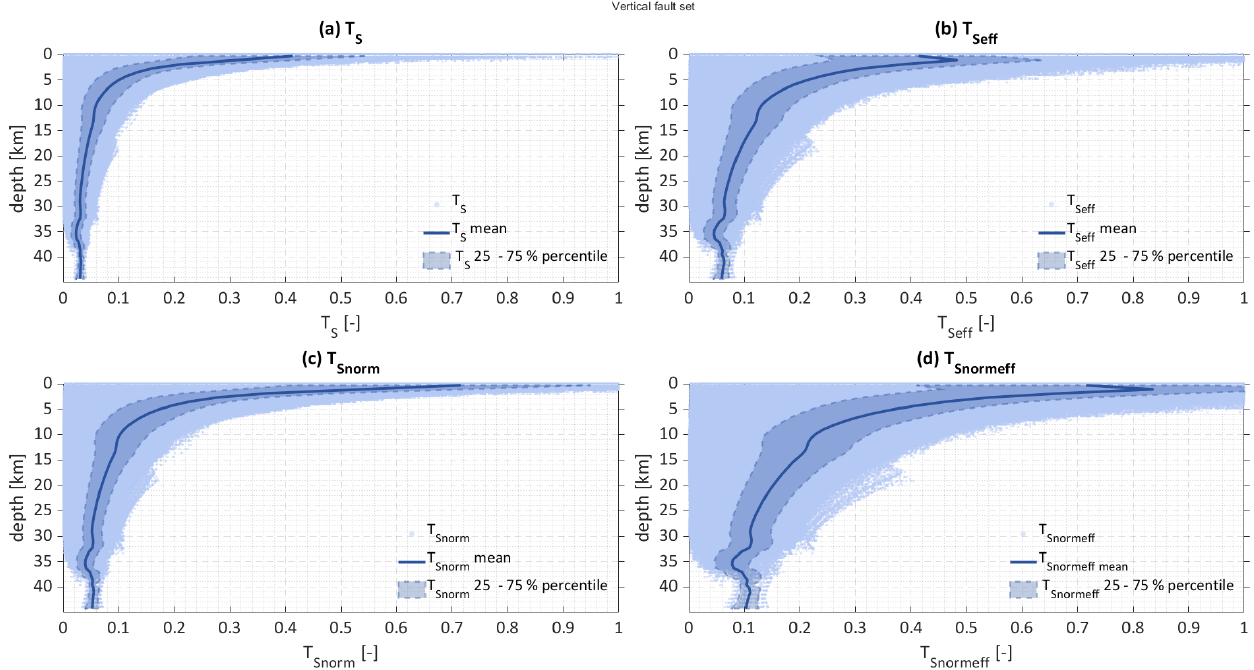
Figure 7. All slip tendency data are plotted vs. depth for the Vertical fault set. The mean slip tendency is plotted as a solid line; the 25%–75% percentile is shown as a shaded